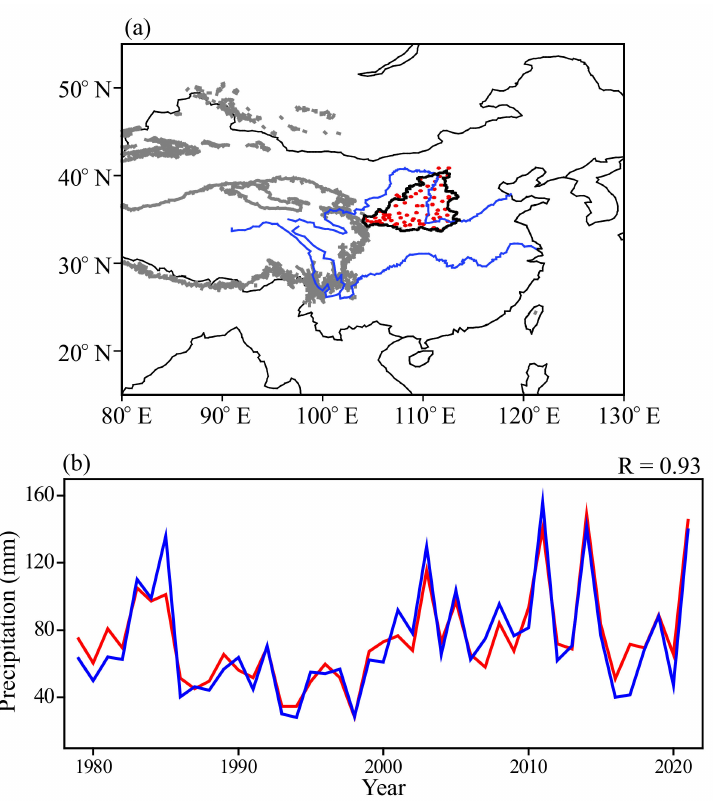
Figure 1. ( a ) The map showing the location of the study area. The blue lines in the north and south of China denote the Yellow and Yangtze Rivers, respectively. The black bold borderline around the Yellow River represents the MRYR region, in which 66 observational stations are highlighted in red dots. The thick gray contour denotes the Tibetan Plateau (3000 m above sea level); ( b ) Time series of the September observational MRYR precipitation index (blue line) and the CMAP-based one (red line) during the period